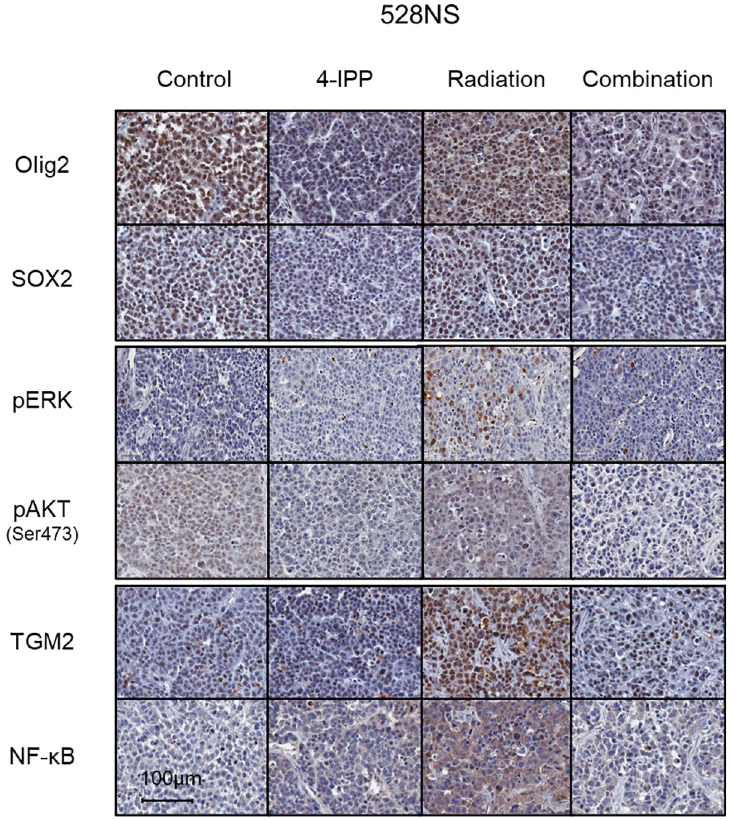
Fig 3. Immunohistochemical analysis of subcutaneous xenograft mouse model. Scale bar, 100 μ m.